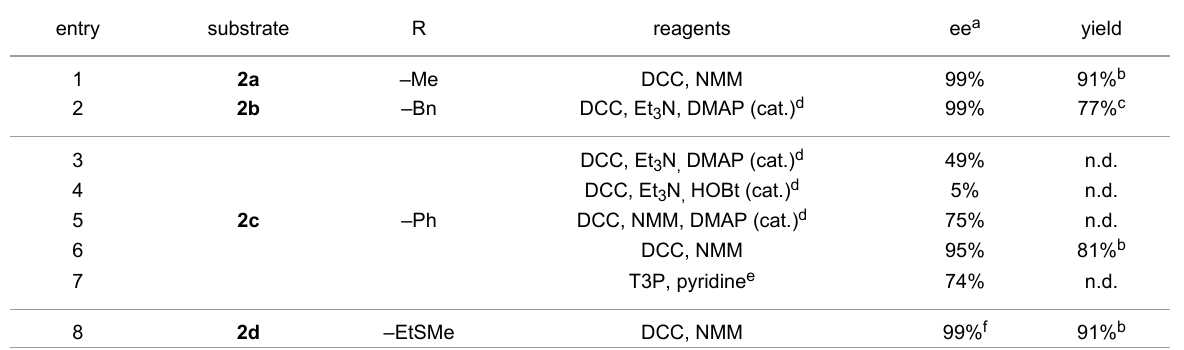
Table 1: Ees and isolated yields of Weinreb amides 5